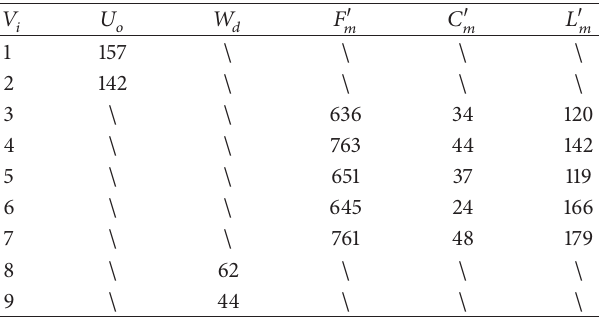
Table 1: The data of nodes for the 9-node problem.